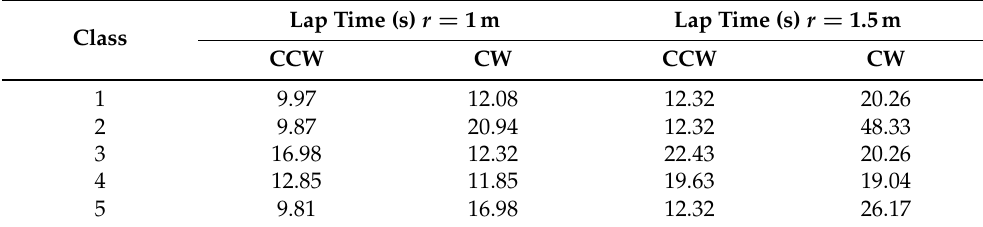
Table 6. Limited performance quantification